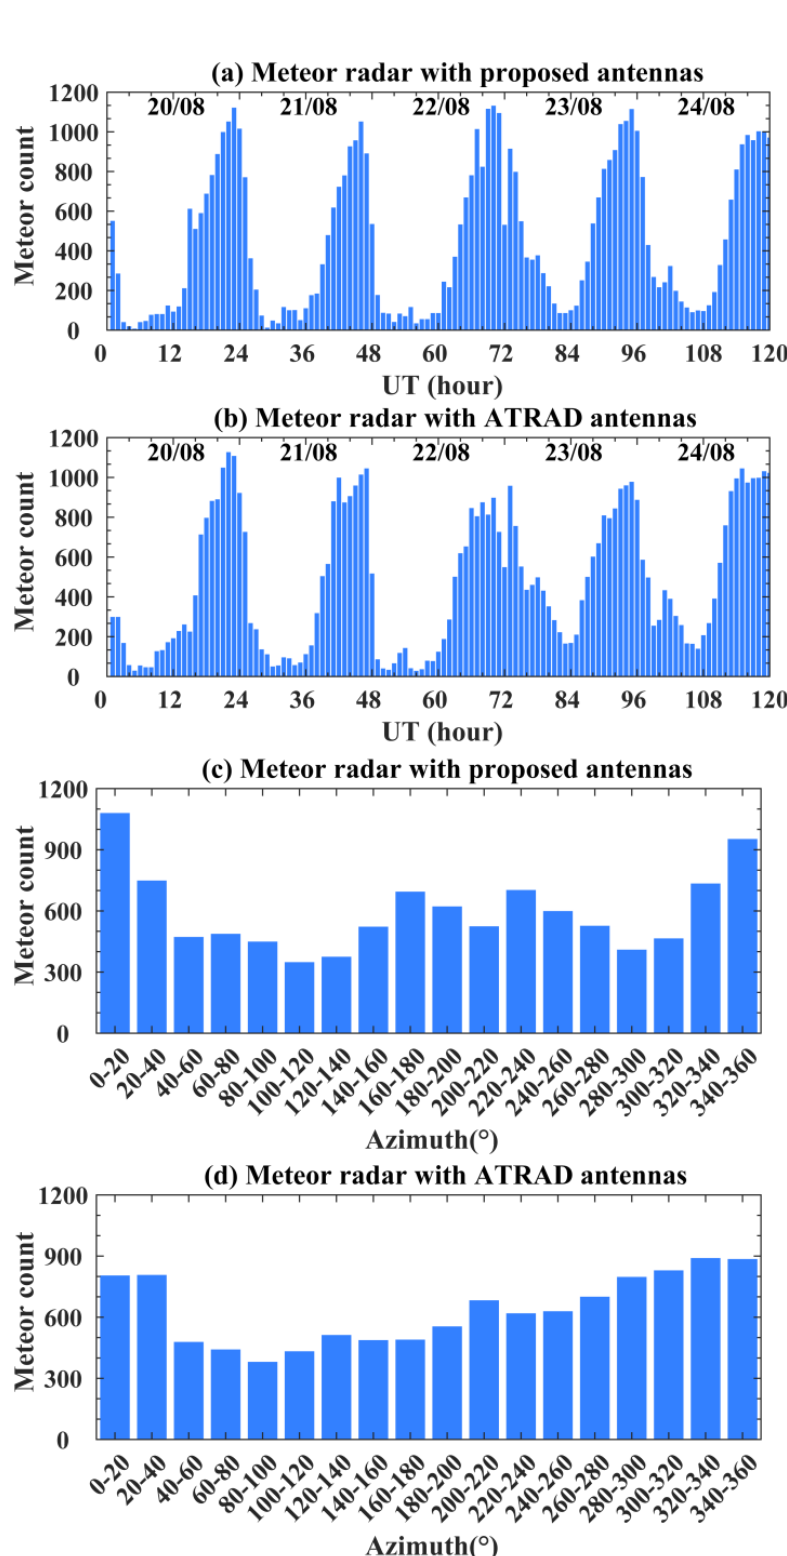
Figure 9. Comparison of count and azimuth distribution of meteors. Meteor radar with antennas of proposed ( a , c ) and ATRAD ( b , d ).